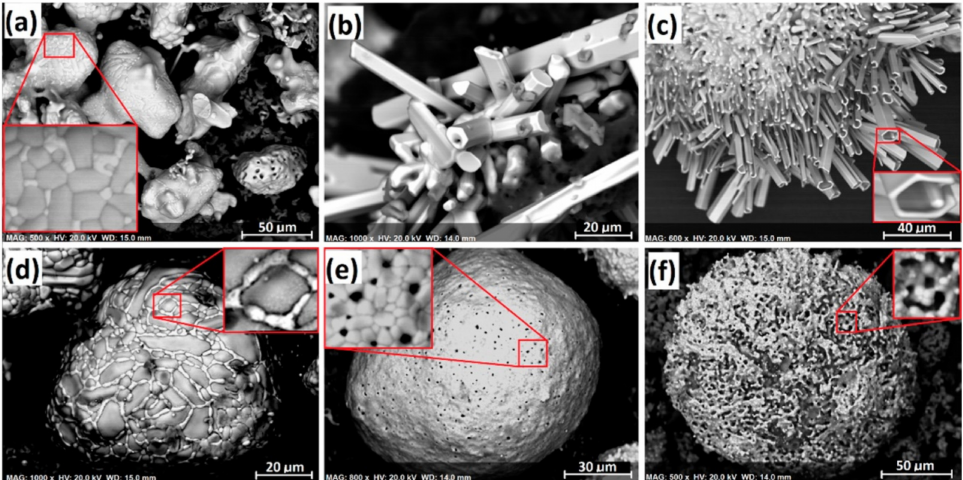
Figure 15. Morphologies of FeCr- and carbide particles produced by segregation using charcoal ( a – c ) and petroleum coke ( d – f ) by Yu et. al.